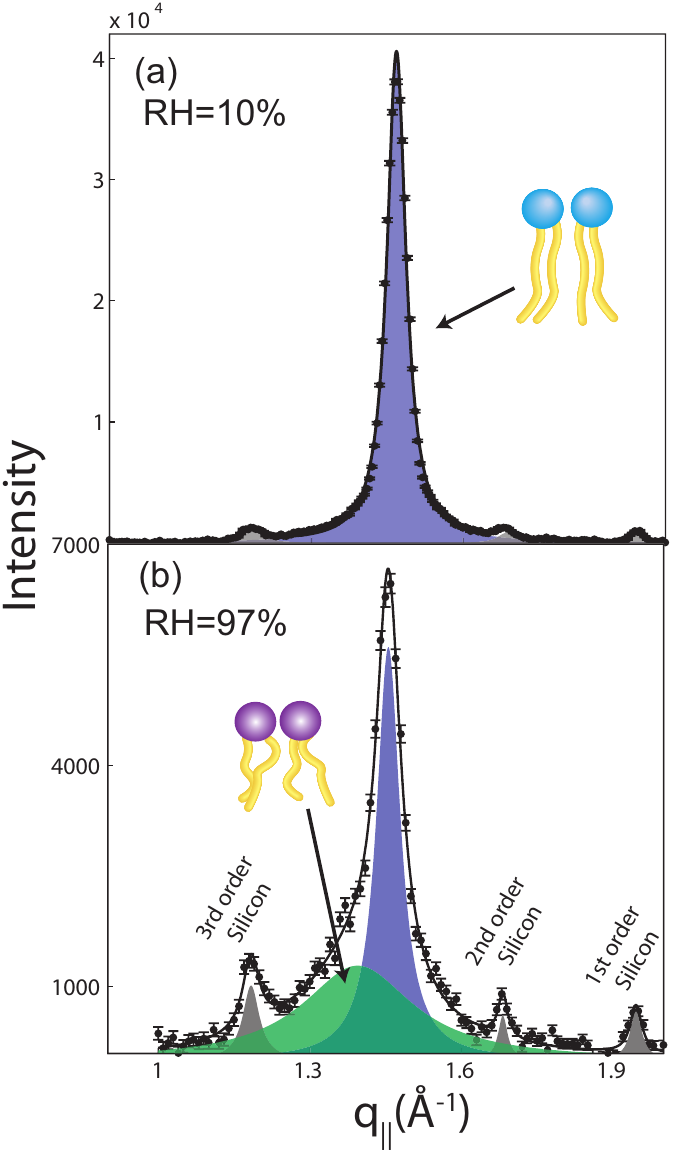
Figure 3. Typical in-plane diffraction at ( a ) 10% relative humidity and ( b ) 97% relative humidity. While the narrow signal at 10% RH indicates that all lipid species take an all-trans (gel) conformation, coexisting gel and fluid signals are observed at high humidity of 97%. Additional signals can be assigned to background scattering from silicon